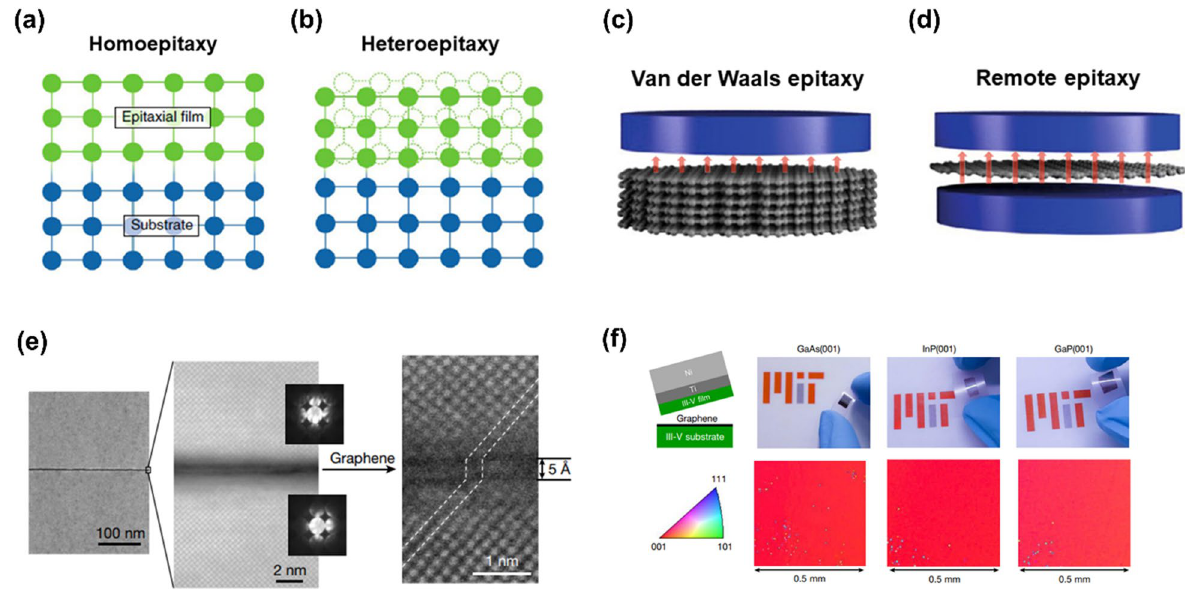
Fig. 1 The schematic of epitaxy techniques for crystal growth and demonstraion of remote epitaxy with III‑V materials. a Homoepitaxy, b Heteroepitaxy, c van der Waals epitaxy and d Remote epitaxy. Figure reproduced from ref, [3, 10], Springer Nature Ltd. e High‑resolution cross‑sectional scanning transmission electron microscopy (STEM) images showing remote epitaxial alignment of the GaAs through the graphene. f Single‑crystalline III‑V membranes exfoliated from graphene/III‑V substrates via remote epitaxy. The large‑scale electron backscatter diffraction (EBSD) maps below show the single crystallinity of each epilayer. Figure reproduced from ref. [1], Springer Nature